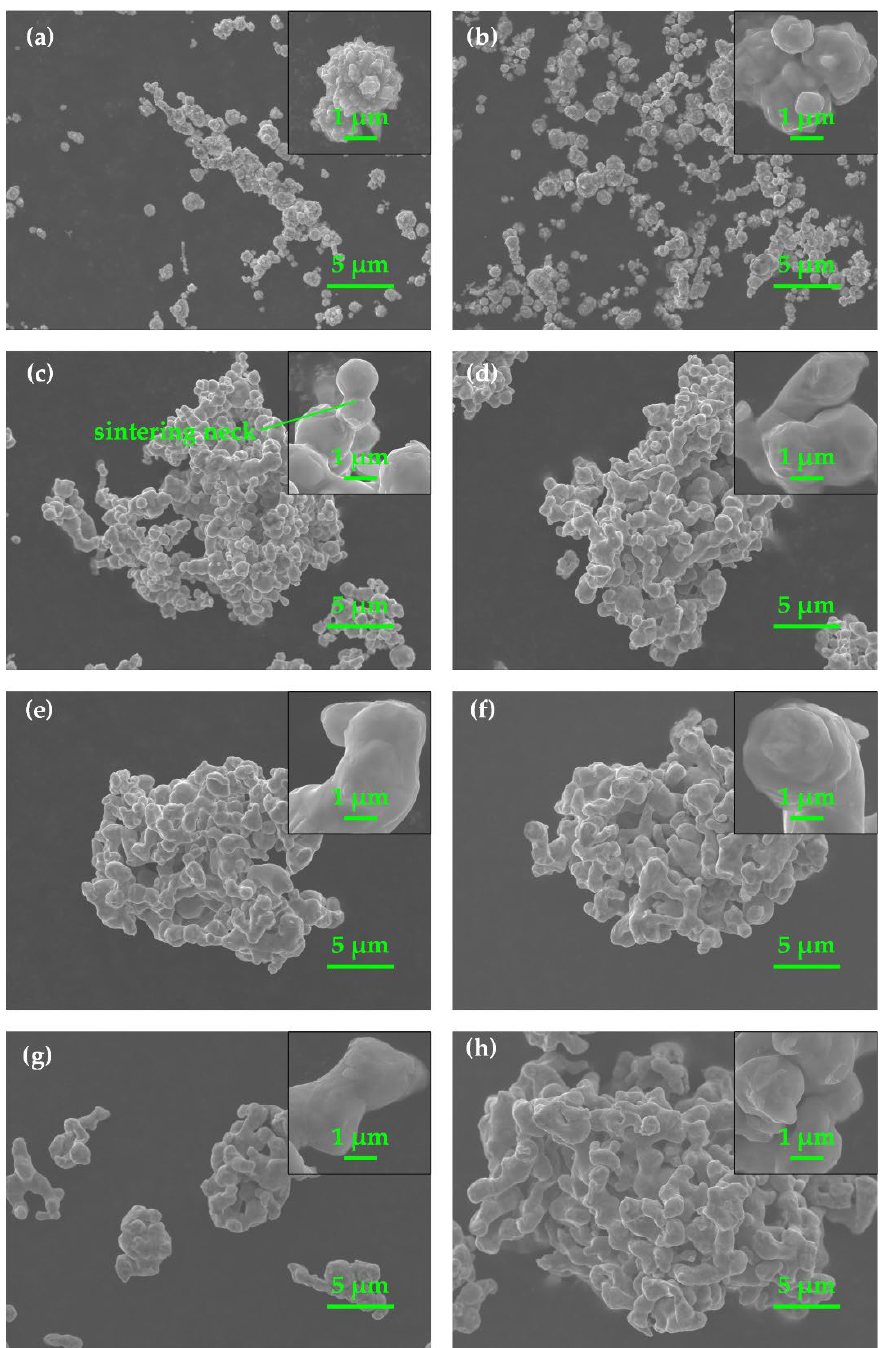
Figure 3. Morphology of raw powder and different pre-sintered clusters: ( a ) the raw powder, ( b ) pre-sintered at 400 °C, 25–38 µm, ( c ) pre-sintered at 500 °C, 25–38 µm, ( d ) pre-sintered at 600 °C, 25–38 µm, ( e ) pre-sintered at 700 °C, 25–38 µm, ( f ) pre-sintered at 800 °C, 25–38 µm, ( g ) pre-sintered at 800 °C, 0–25 µm, ( h ) pre-sintered at 800 °C, 38–43 µm.